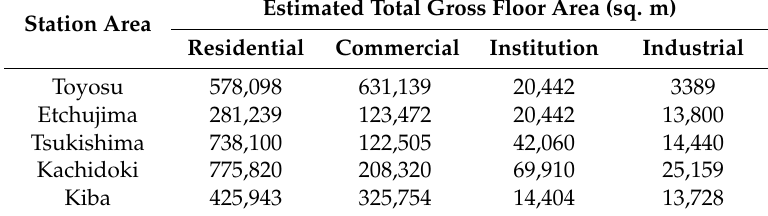
Table 4. Estimated total gross floor space of Toyosu, Etchujima, Tsukishima, Kachidoki, and Kiba station areas.